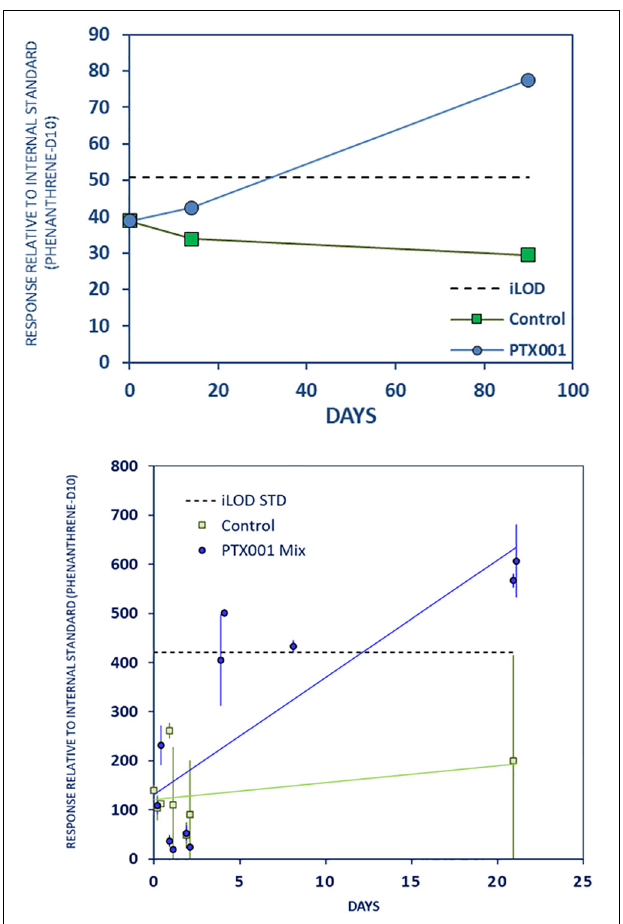
FIGURE 3 | Strong gradual leaching of dibutylphenol from PTX001 to stomach oil. Further caption details as in Figure 2